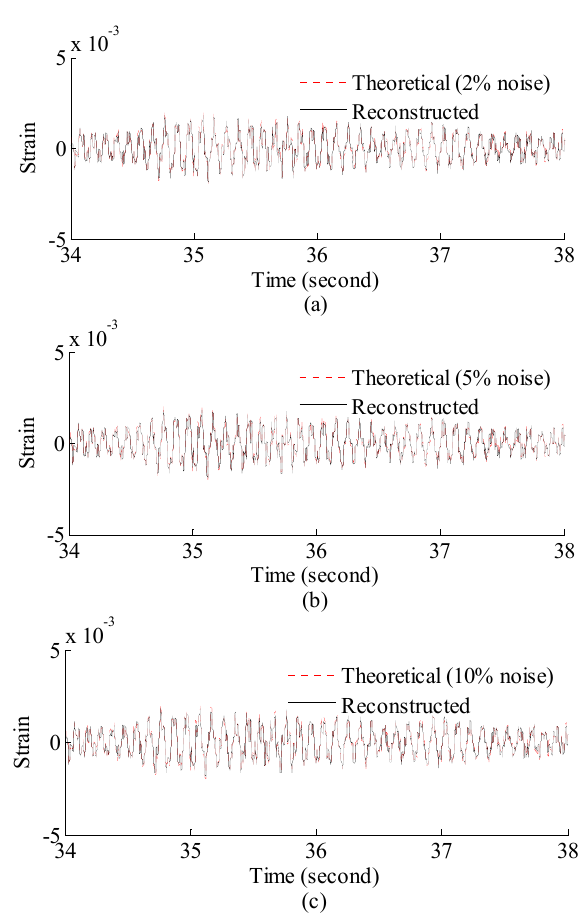
Figure 6. Reconstructed and theoretical strain responses for the location of interest under ( a ) 2%; ( b ) 5%; ( c ) 10% noise level. Results are concentrated on 34–38 s for clear presentation.